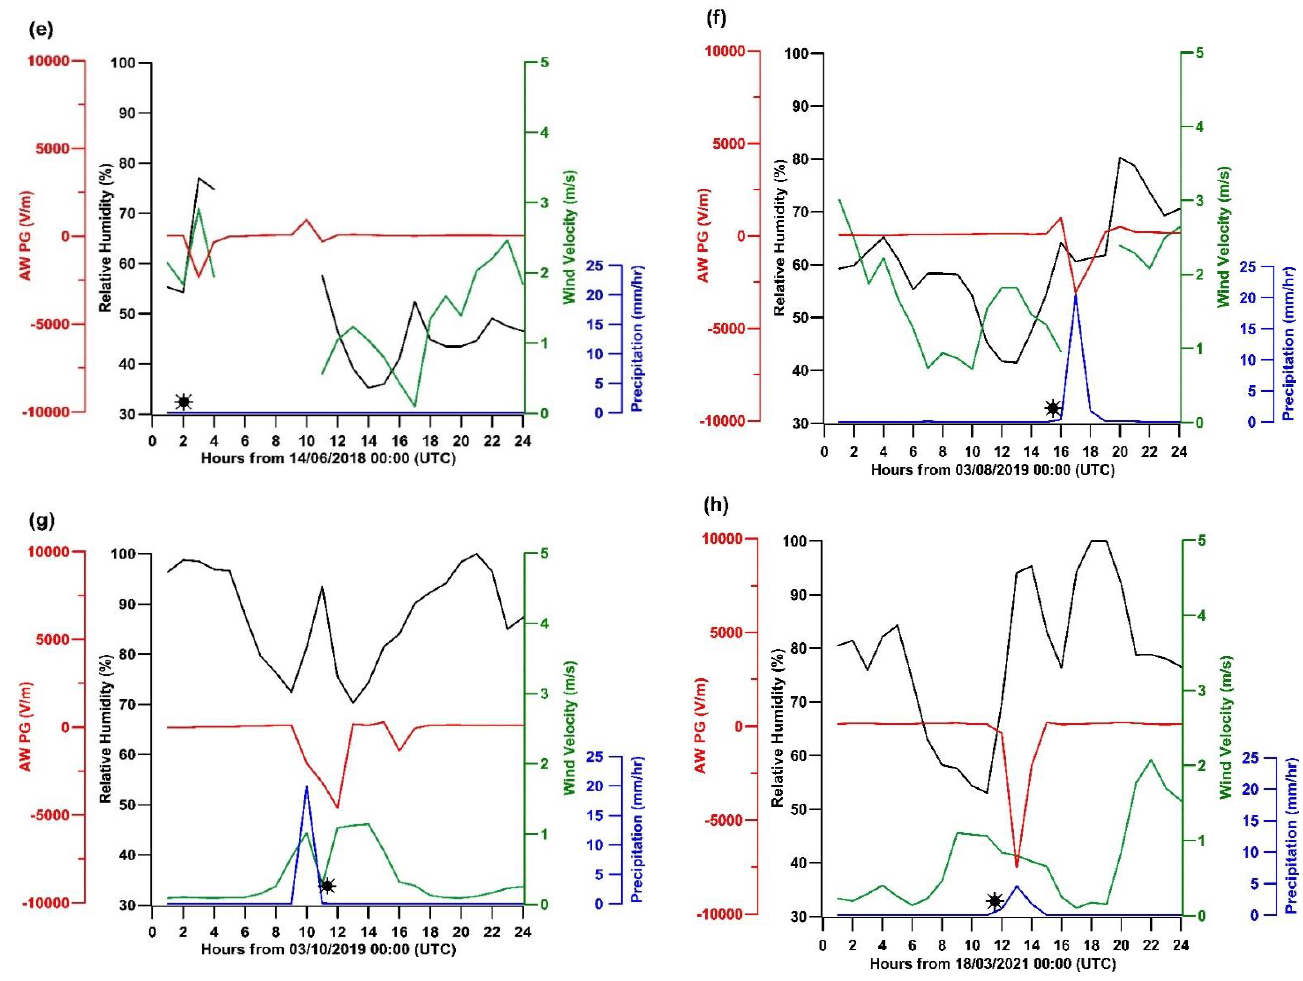
Figure 2. Hourly PG, RH, wind velocity and hourly precipitation rate of: ( a ) Hail event 22/05/2012; ( b ) Hail event 22/03/2013; ( c ) Hail event 11/04/2014; ( d ) Hail event 02/07/2016; ( e ) Hail event 14/06/2018; ( f ) Hail event 03/08/2019; ( g ) Hail event 03/10/2019; ( h ) Hail event 18/03/2021. The asterisk denotes the start of hail.